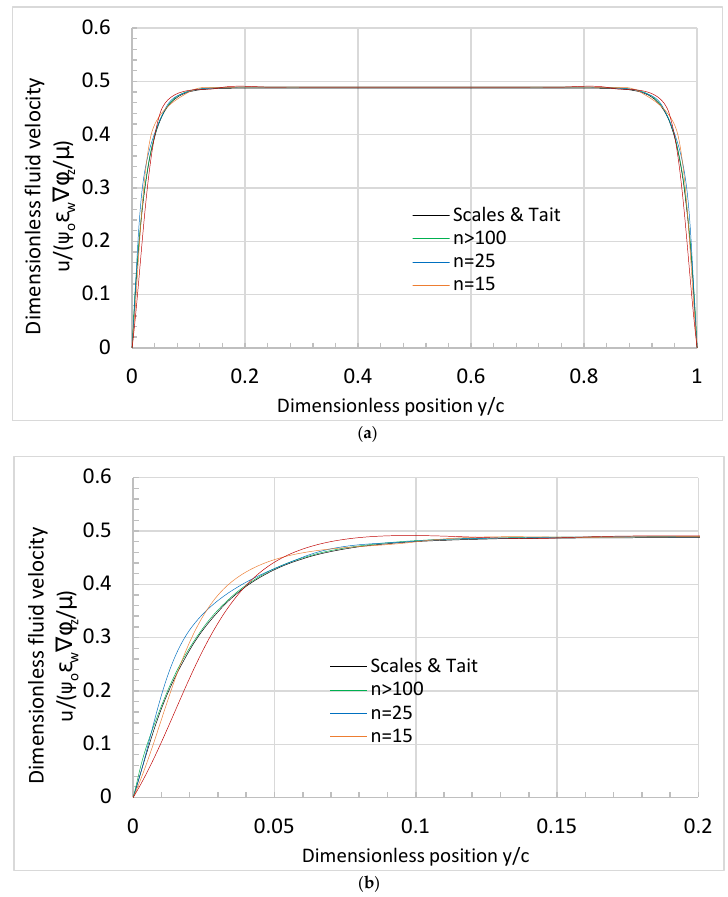
Figure 7. ( a ) Dimensionless velocity in a parallel plate channel. Single material. Charged medium with uncharged walls. ( b ) Dimensionless velocity in a parallel plate channel. Single material. Charged medium with uncharged walls. Detail in the vicinity of the wall. Table 1. Fluid velocity and flow per unit section relative errors as a function of the number of cells. Parallel plate channel. Single material. Charged medium with uncharged walls.